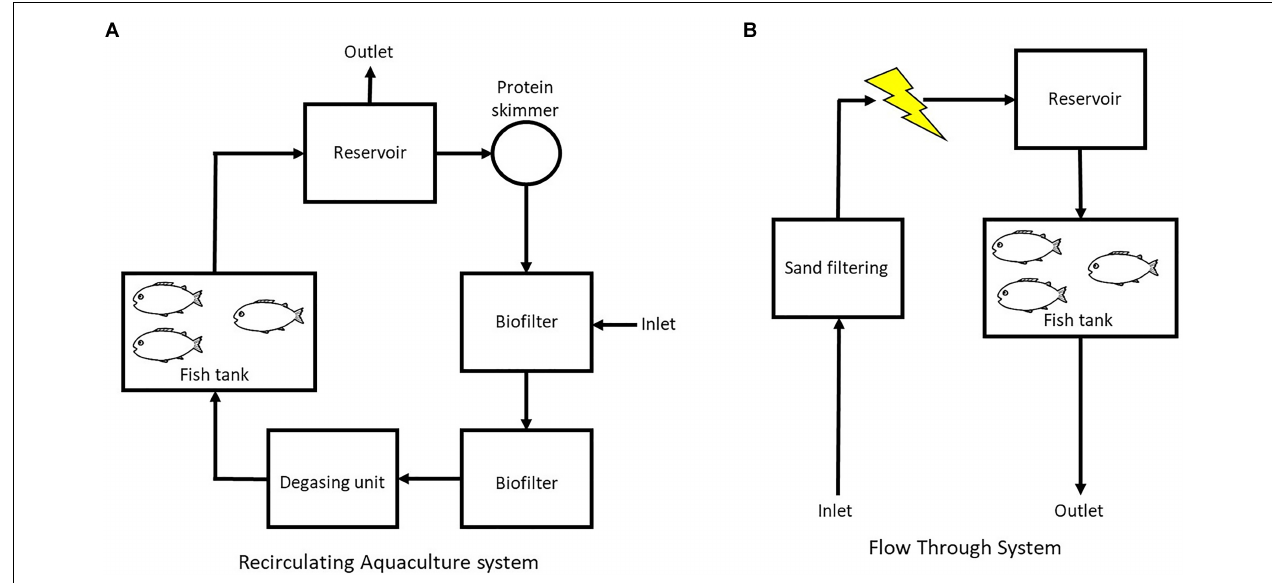
FIGURE 1 | Schematic set up of (A) the recirculation aquaculture system (RAS) and (B) the flow through system (FTS) used in this study.